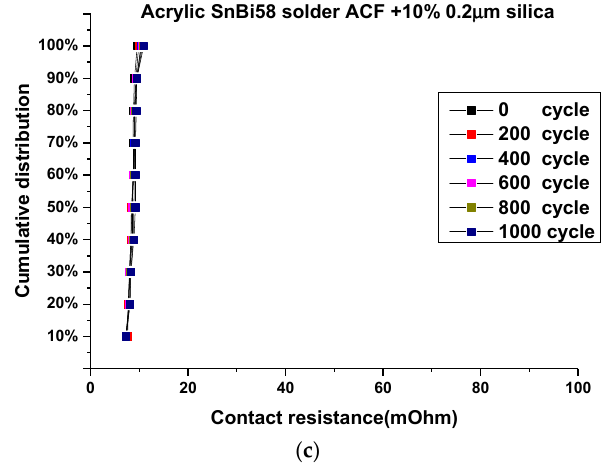
Figure 26. Solder joint contact resistances of acrylic based SnBi58 solder ACFs up to 1000 cycles T/C reliability as a function of ( a ) 0, ( b ) 5, and ( c ) 10 wt % 0.2 μ m silica fillers addition.